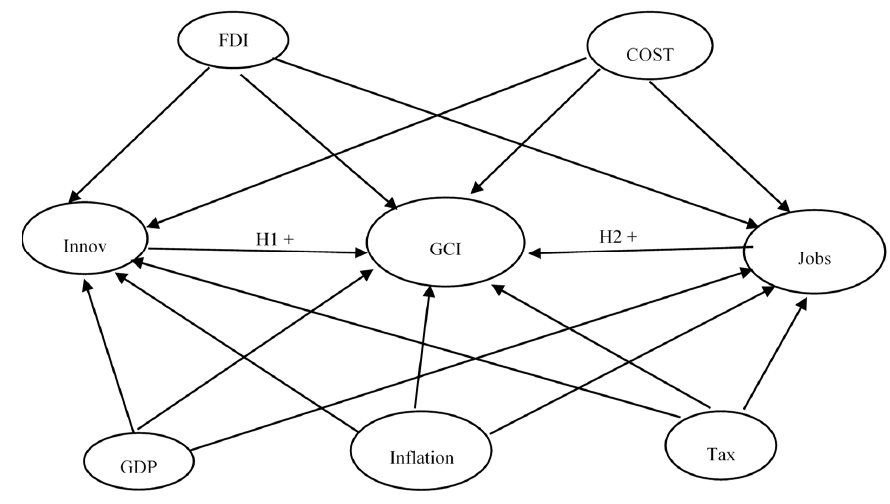
Figure 2. Research model with hypotheses.